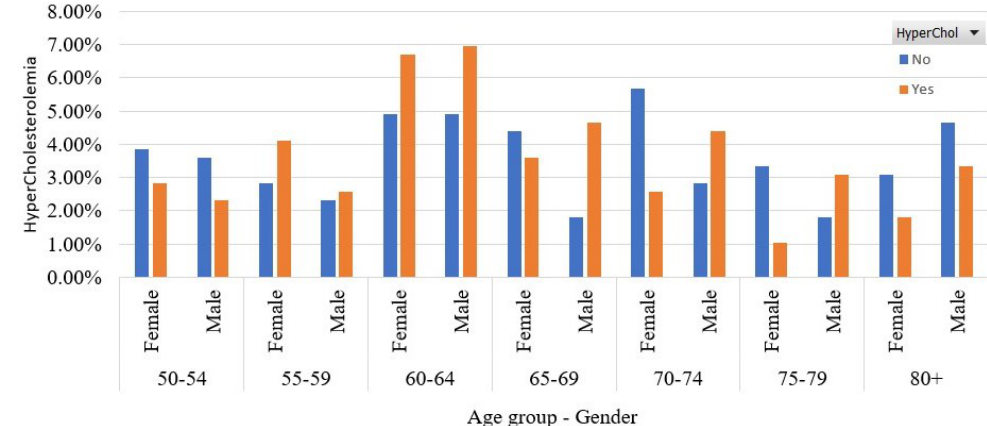
Figure 2. Participants’ distribution per age group and gender type in the balanced